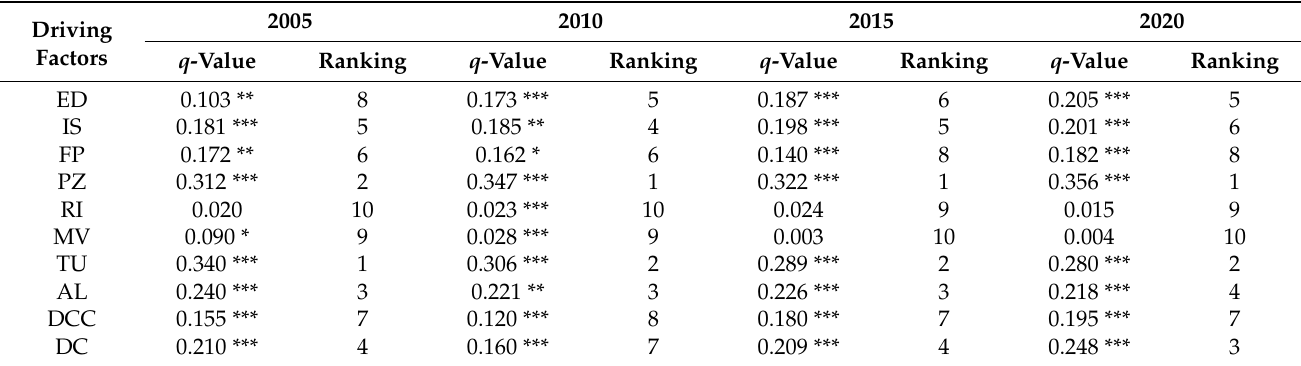
Table 3. Factor detection results for county sprawl